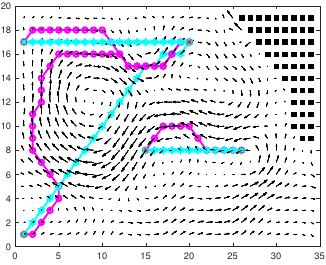
Figure 7. The routes established by the traditional A* algorithm and the improved A* algorithm from the grids (1,1), (26,8), and (1,17) to the grids (20,17), (15,8), and (20,17) in the grid map. The paths generated by the traditional A* algorithm are indicated by the cyan lines. The paths generated by the improved A* algorithm are indicated by the magenta